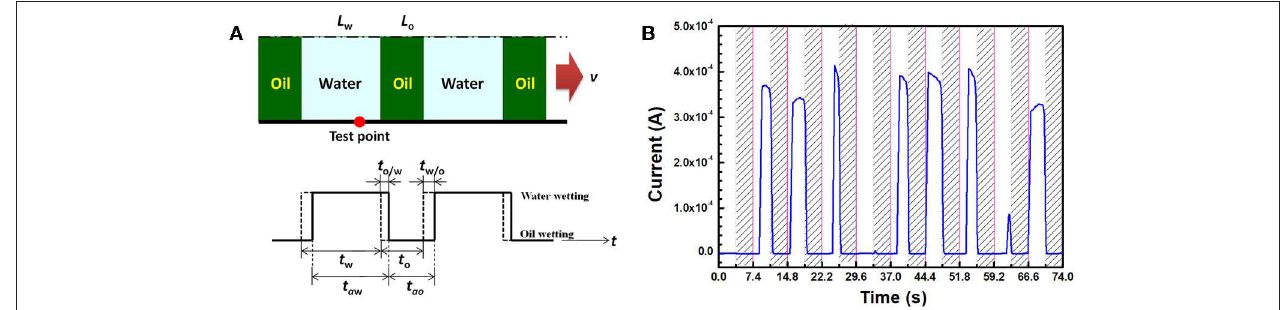
FIGURE 4 | (A) Simplification of intermittent flow pattern as an “alternate slug model” and (B) the anodic current transient detected on a rotating disk electrode alternately wetted by oil and water by the “alternate wetting cell” test method (Wang et al., 2019a). In (A) , t w is the time of water slug passing though the test point, t w / o is the time of water-replacing-oil, and t o / w is the time of oil-replacing-water. In (B) , the rotation is 600 rpm, the alternate period is 7.4s for the current response and the applied anodic potential is + 100mV vs. open circuit potential.